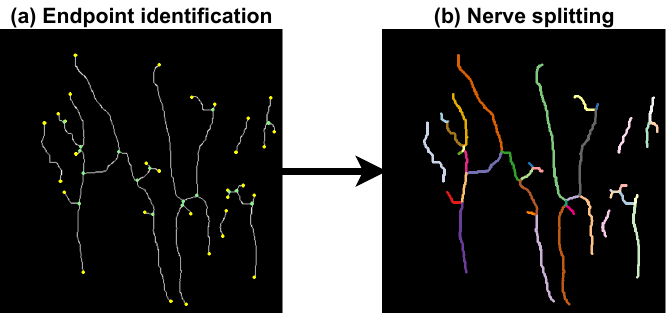
Figure 3. Nerve splitting process. ( a ) The nerve extreme and the nerve intersection pixels are marked in yellow and green, respectively. ( b ) Individual nerve segments are displayed in different